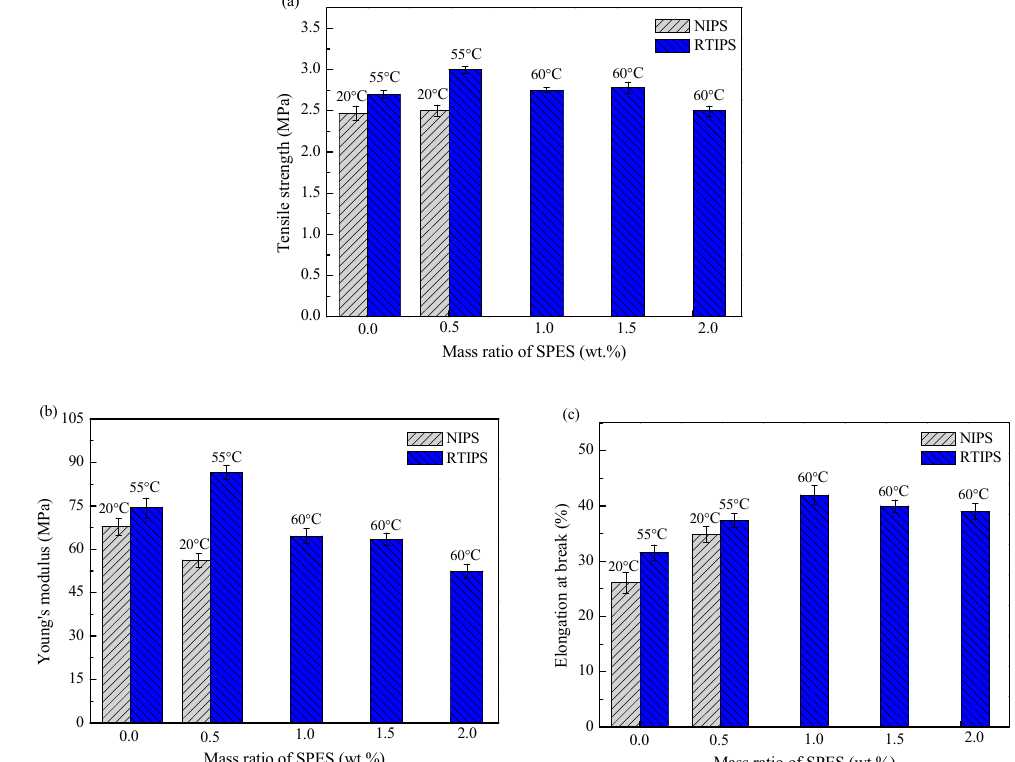
Figure 13. Mechanical properties of PES membranes.